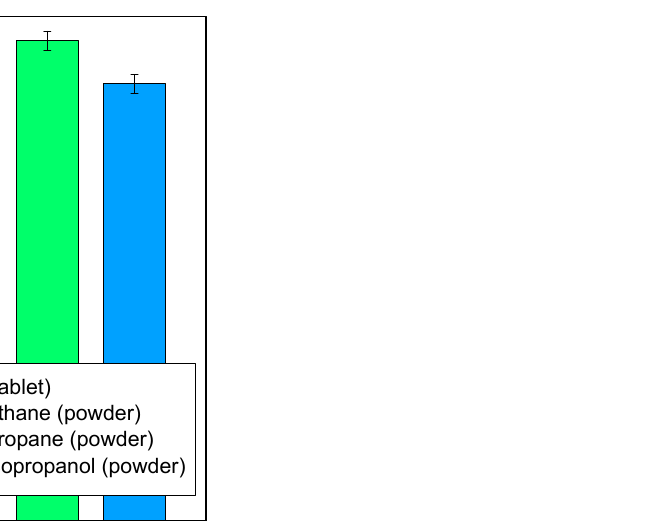
( b ) Figure 3. ( a ) The conversion rate dependence of the methane hydrate on the particle diameter D 0 ( T = 268 K, pore diameter d p = 0.2 µm, dissociation time for all the diameters is 14,400 s); ( b ) The de- pendence of the total dissociation time ( τ 0 ) of the methane hydrate on diameter D 0 ( T = 268 K, pore diameter d p = 0.2 µm) [67].